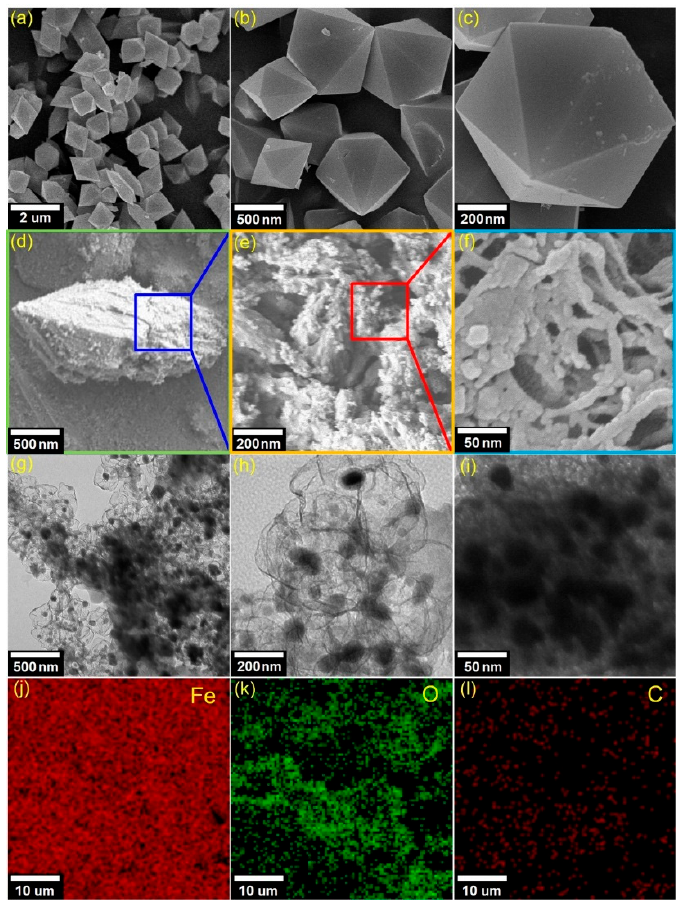
Figure 3. SEM images of Fe 3 O(BDC) 3 ( a – c ) and MPC700 ( d – f ); TEM ( g – i ), and EDS mapping ( j – l ) images of MPC700.